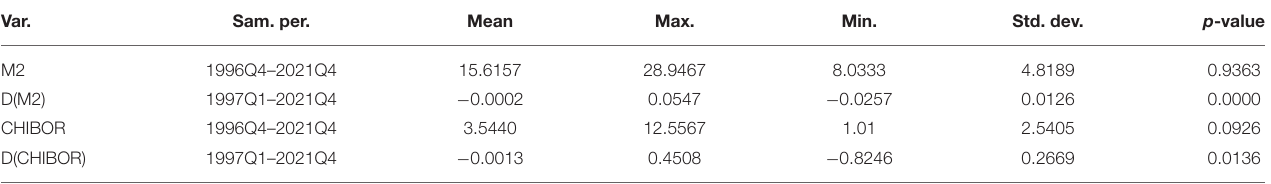
TABLE 1 | Statistical description of the main variables in the article. Var. Sam. per. Mean Max. Min. Std. dev. p -value